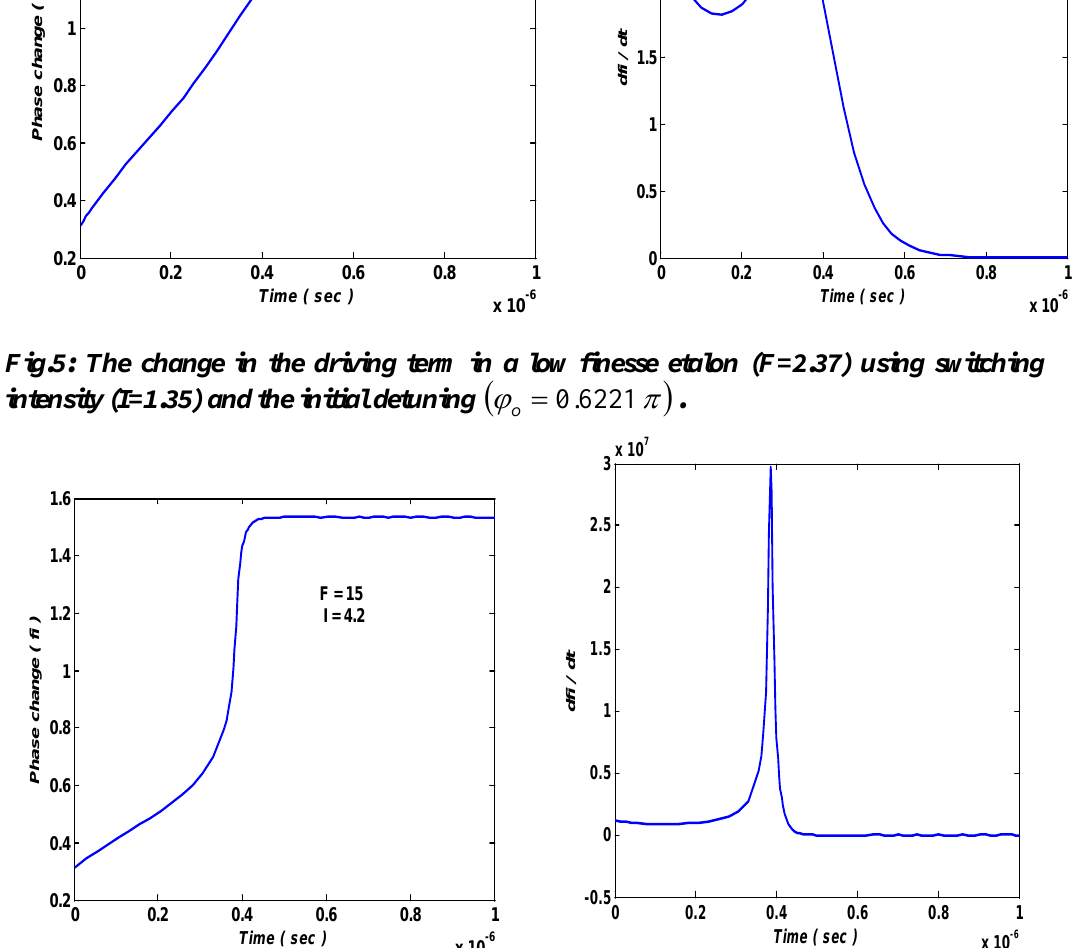
Fig.6: The change in the driving term for a finesse value (F=15) using switching intensity (I=4.2) and the initial detuning ( ) πϕ 6221.0 =